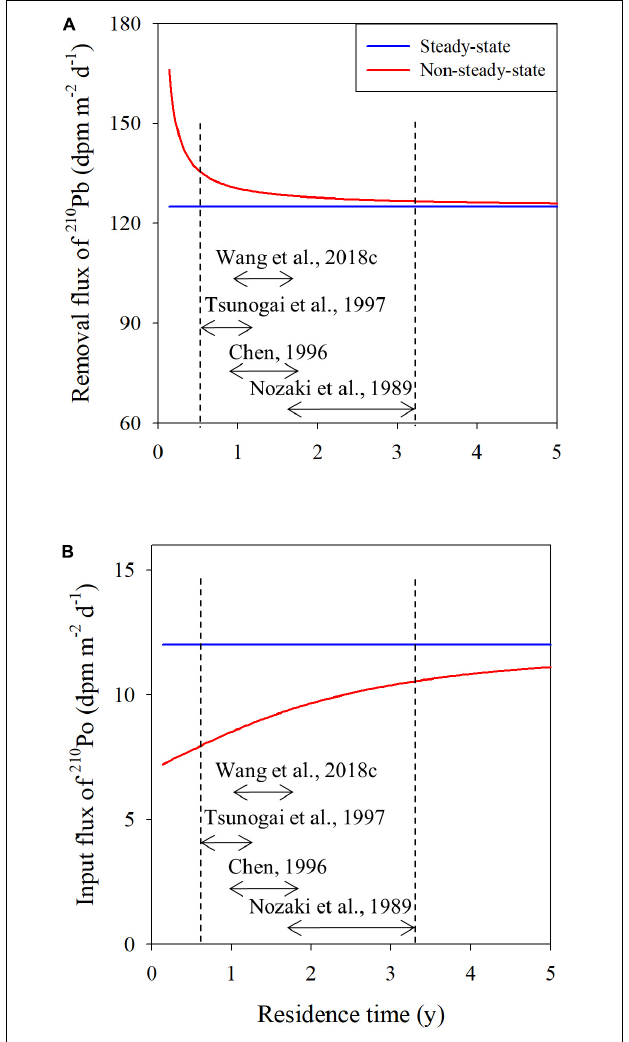
FIGURE 4 | Net removal flux of total 210 Pb (in disintegrations per minute per square meter per day; A ) and net input flux of total 210 Po (in disintegrations per minute per square meter per day; B ) from the upper 0–50 m in the East China Sea (ECS) shelf water, calculated based on the steady-state and non-steady-state models accounting for the advection of water. The dotted lines represent the range of the previously reported residence times in the ECS shelf